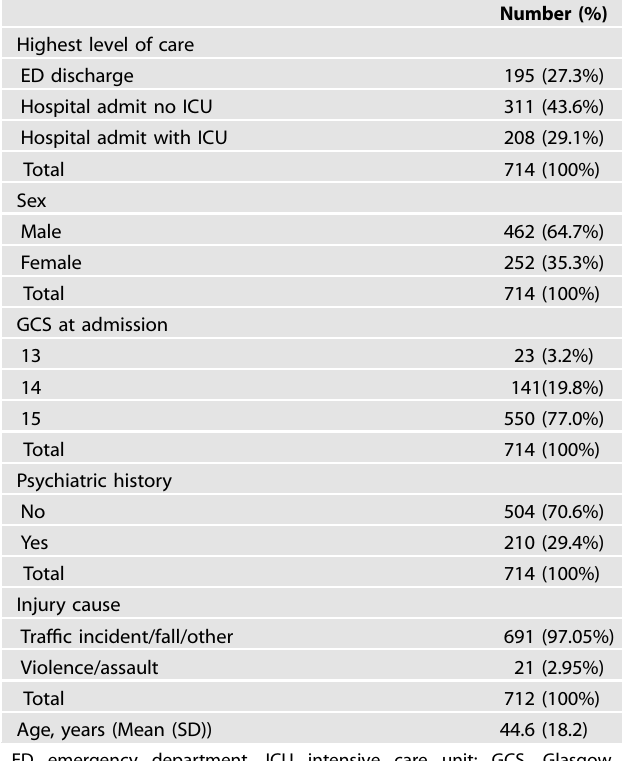
Table 1. Demographic and clinical characteristics of the study sample ( N =